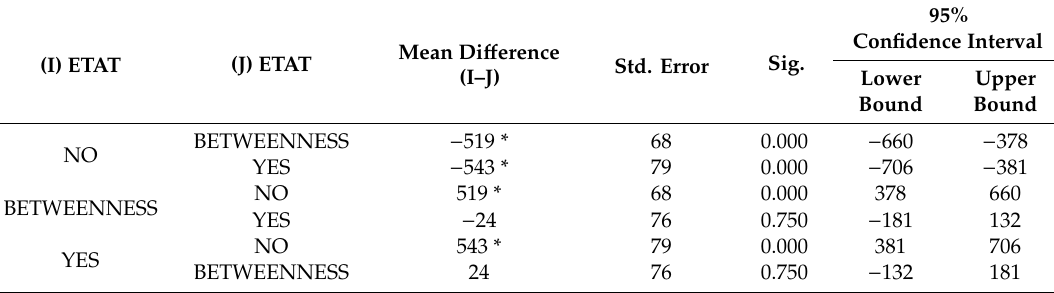
Table 13. Post hoc tests: Multiple comparisons